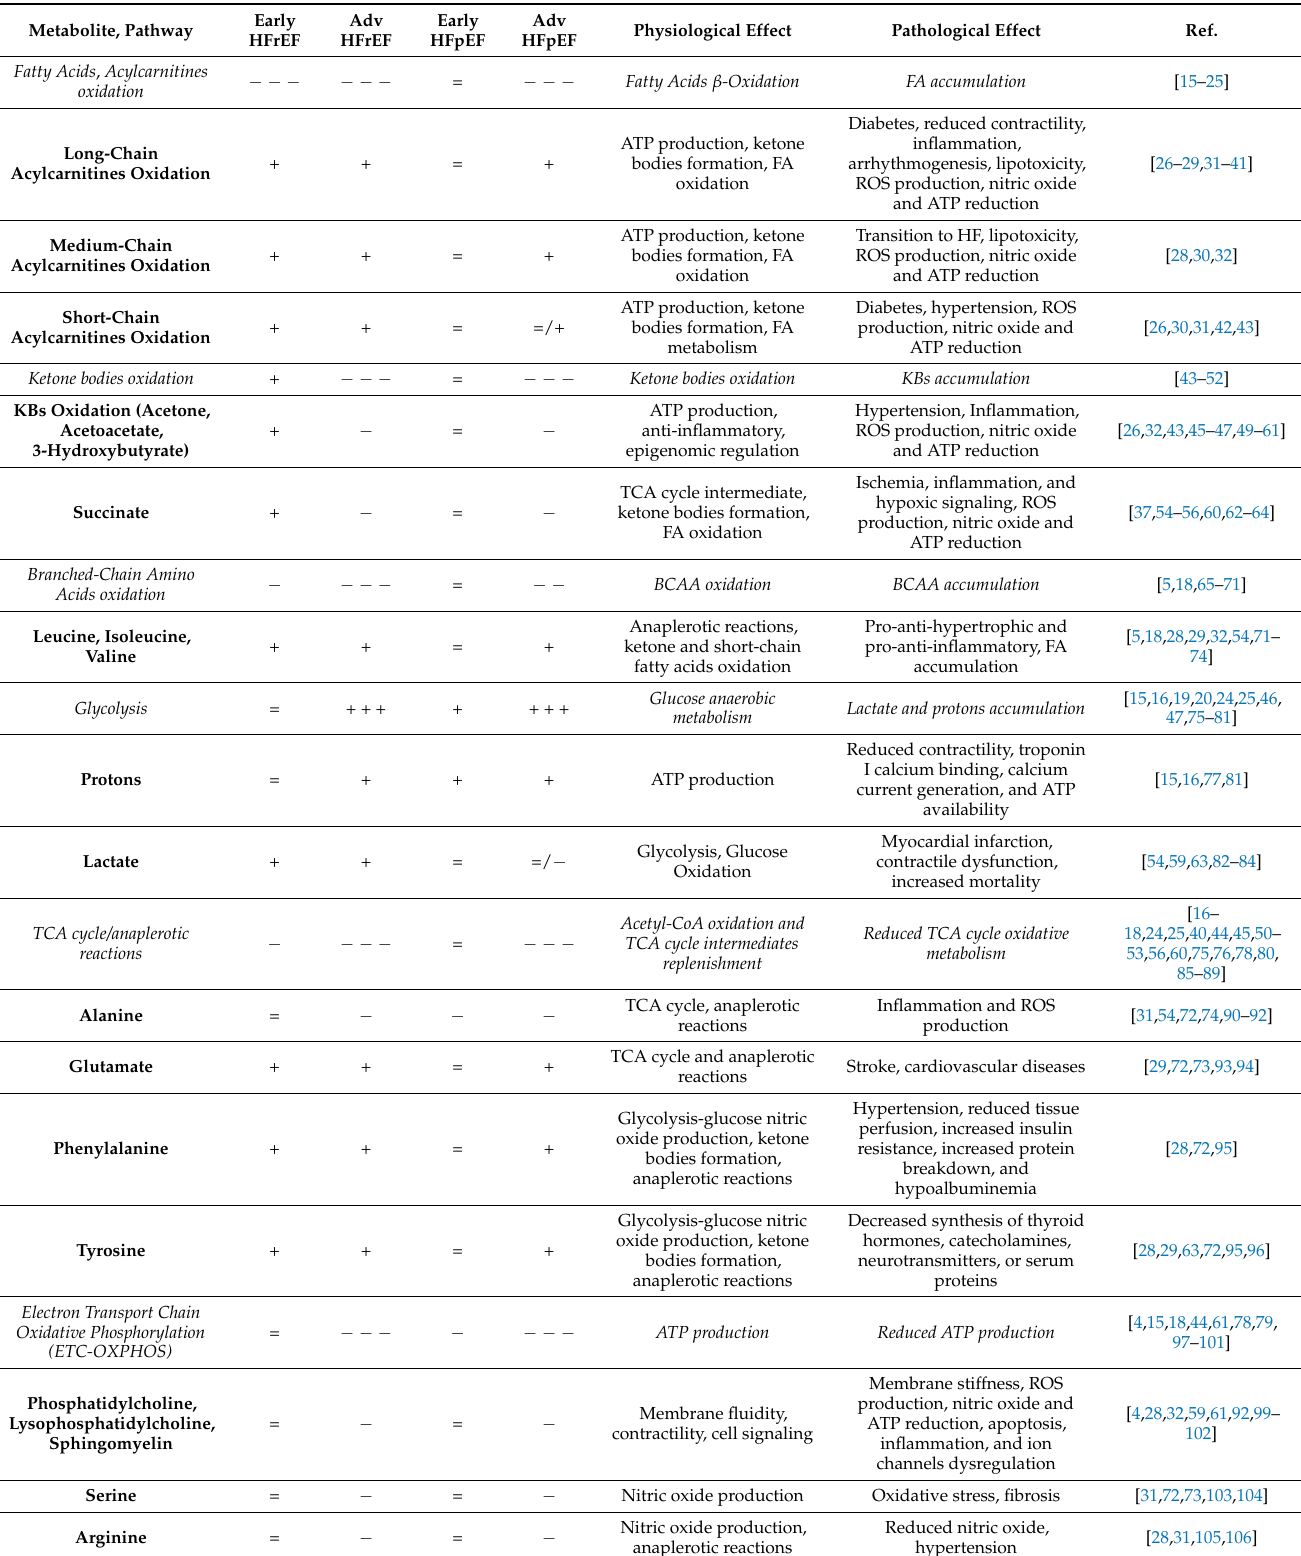
Table 1. Summary of metabolic alterations and relative metabolites associated with HFrEF and HFpEF. Physiological and pathological effects are listed according to the relative metabolic markers.